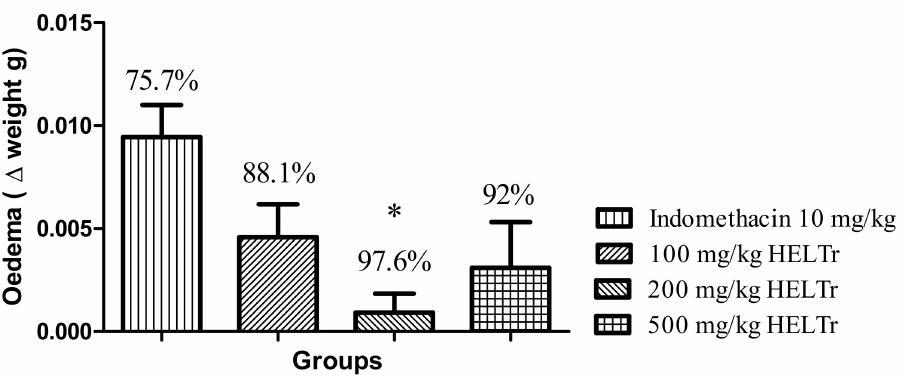
Figure 7. Effect of the HELTr on the inhibition of carrageenan-induced abdominal edema in adult zebrafish at the maximum edema peak (0–5 h). Each column represents the mean ± standard error of the mean ( n = 12/group). The numbers above the bar indicate the percentage of inflammation inhibition for the positive control (indomethacin 10 mg/kg) and HELTr (100–200–500 mg/kg, p.o.) groups. Statistical analysis was performed through one-way ANOVA followed by the post hoc Tukey test. (* p ≤ 0.05 control (indomethacin) vs. 200 mg/kg of the HELTr).